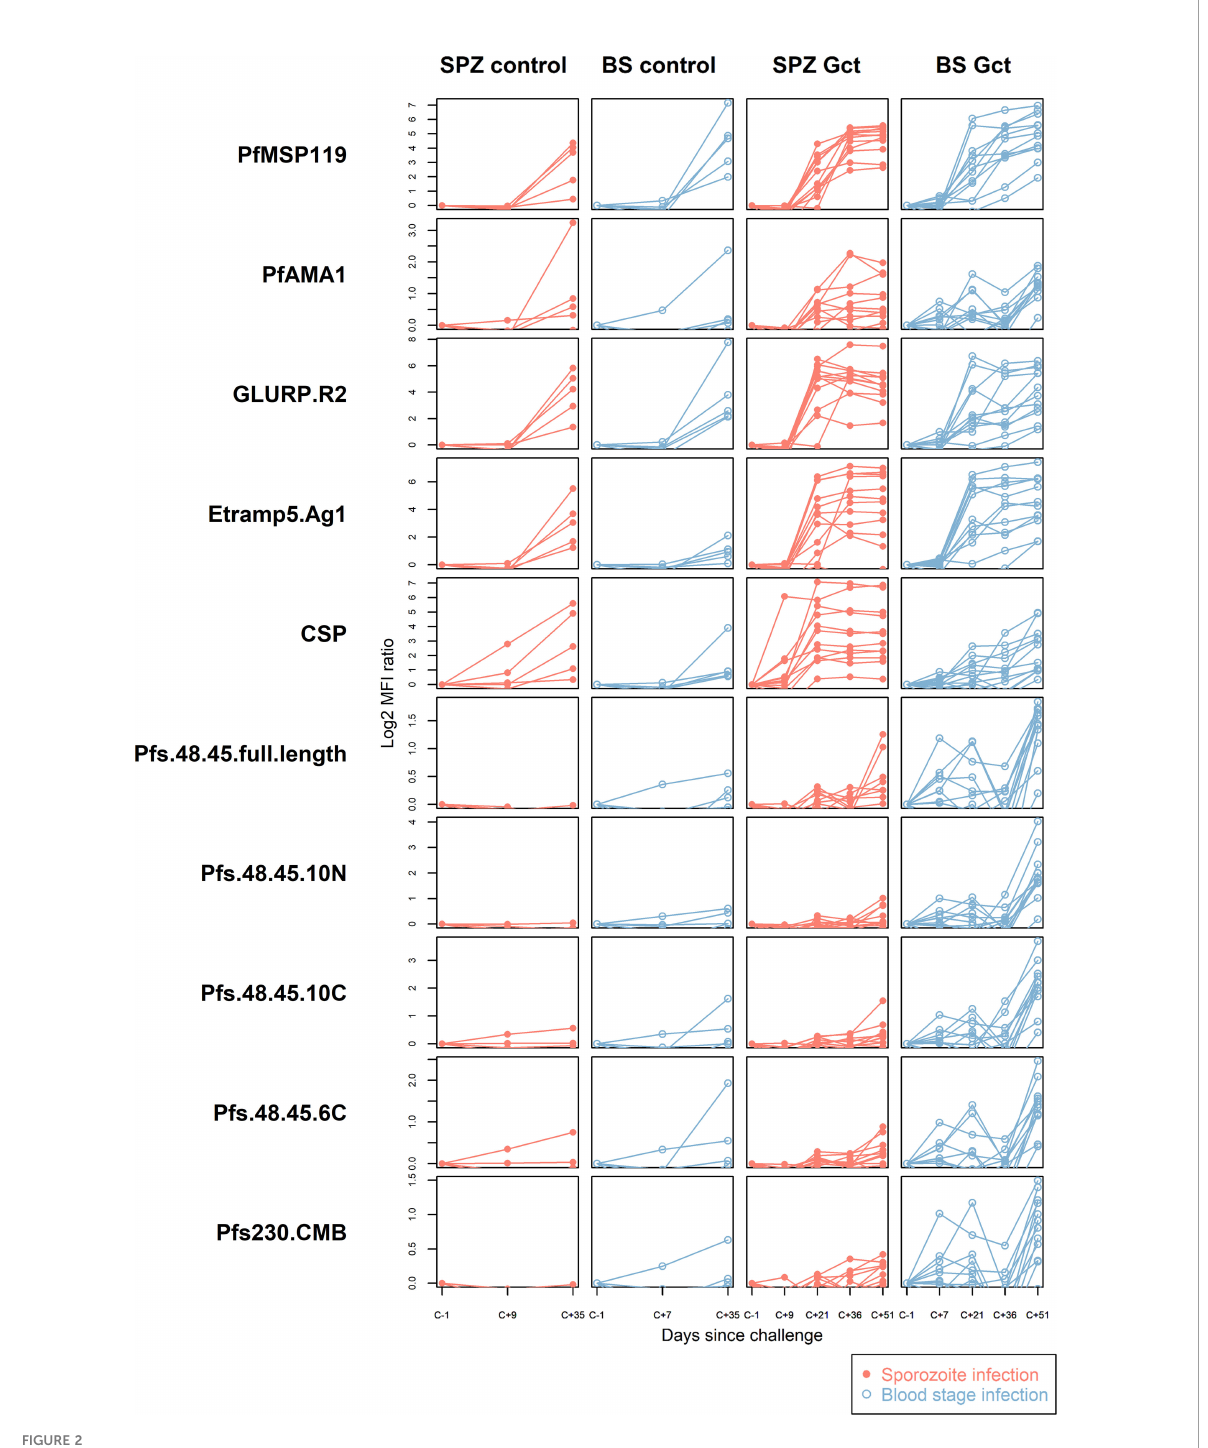
FIGURE 2 Antibody responses to puri fi ed recombinant proteins. IgG antibody responses to a selection of puri fi ed sporozoite, asexual and sexual stage antigens. Statistical analysis of response over time compared to baseline for all antigens is in Supplemental Table S3. In all plots, red solid circles denote mosquito bite (sporozoite) infection cohorts (SPZ Control, SPZ Gct) and blue hollow circles denote asexual parasite infection (BS Control, BS Gct). Data are presented as log2 median fl uorescence intensity (MFI) ratios of response over baseline, each line representing a single